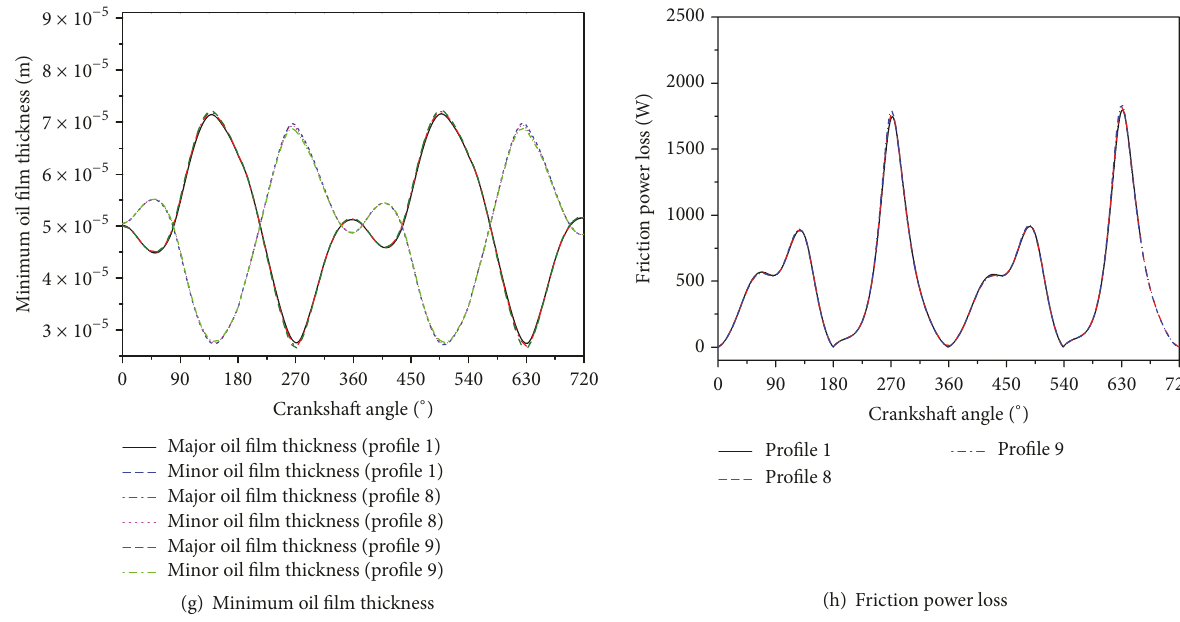
Figure 18: Effect of horizontal profile on lubrication